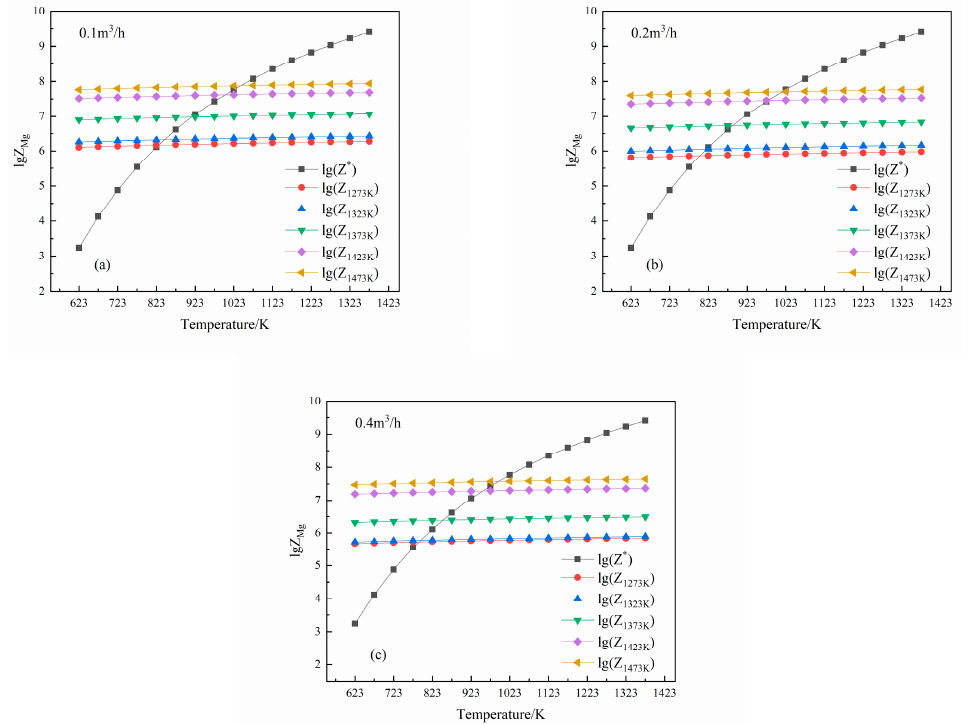
Figure 6. Relationship between temperature and average collision times of Mg vapor: ( a ) 1273–1473 K heating and 0.1 m 3 / h Ar, ( b ) 1273–1473 K heating and 0.2 m 3 / h Ar, ( c ) 1273–1473 K heating and 0.4 m 3 / h